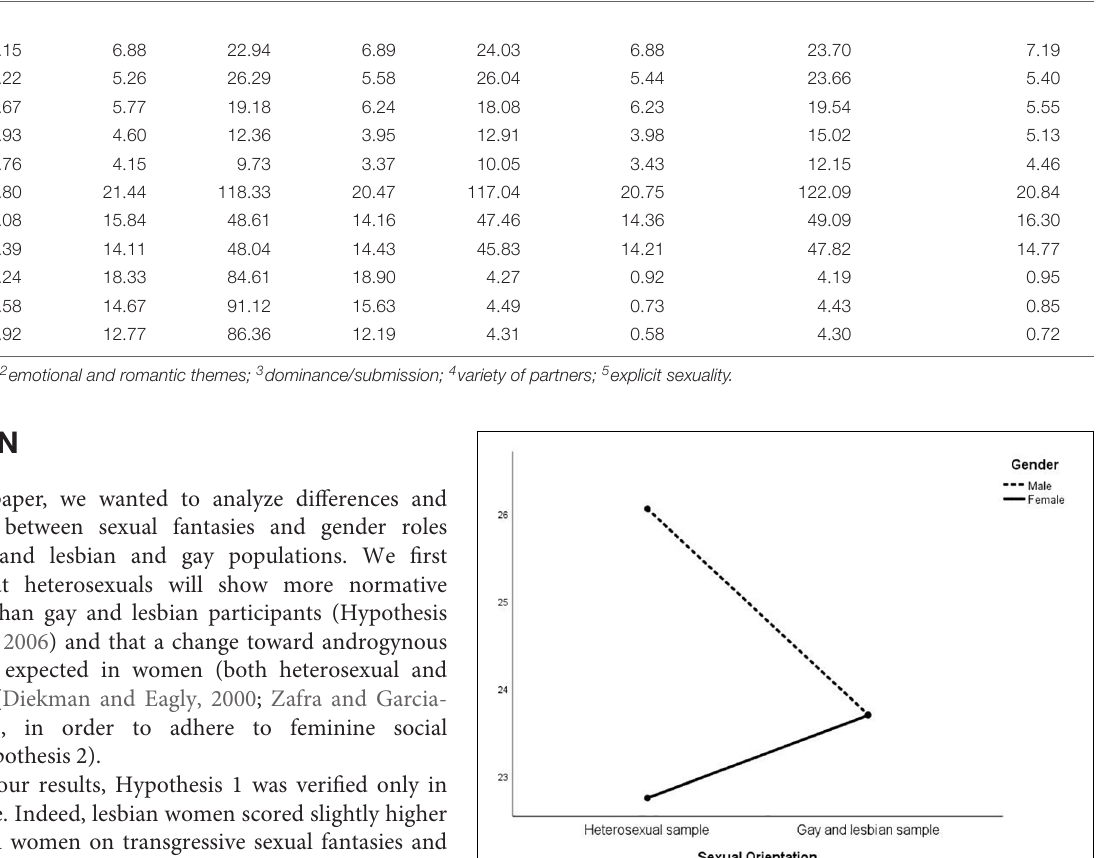
TABLE 3 | Between-subject effects on the EIQ factors.